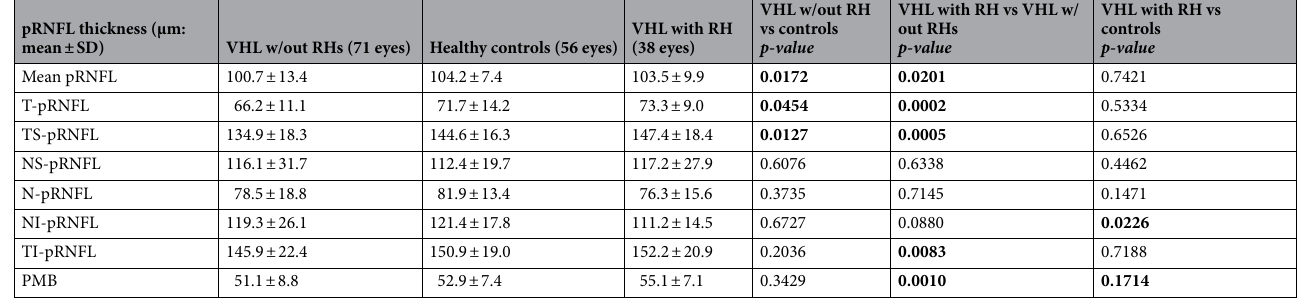
Table 1. Peripapillary retinal nerve fiber layer (pRNFL) thickness in VHL eyes with or without RH and healthy controls. N-pRNFL, nasal sector-peripapillary Retinal Nerve Fiber Layer; NI-pRNFL, nasal-inferior sector-peripapillary Retinal Nerve Fiber Layer; NS-pRNFL, nasal-superior sector-peripapillary Retinal Nerve Fiber Layer; PMB, papillo-macular bundle; RH, retinal hemangioblastomas; T-pRNFL, temporal sector- peripapillary Retinal Nerve Fiber Layer; TI-pRNFL, temporal-inferior sector-peripapillary Retinal Nerve Fiber Layer; TS-pRNFL, temporal-superior sector-peripapillary Retinal Nerve Fiber Layer; VHL, Von Hippel Lindau disease; w/out, without. Significant p value in